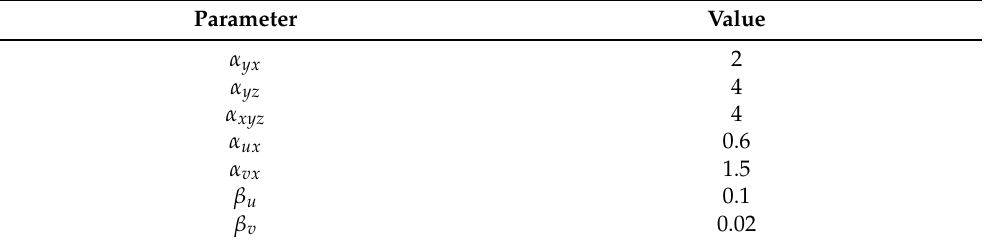
Table 3. Parameter values used in the simulation for the model with forced dissociation (Equation (4)). Parameter